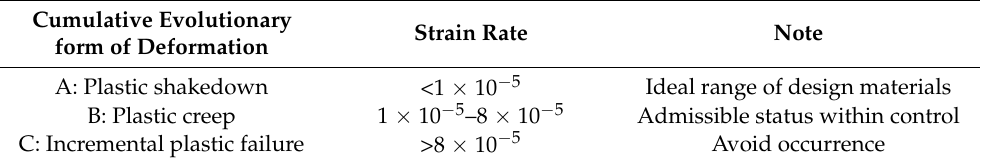
Table 2. Relationship between manner of elastoplastic response and plastic strain rate of subgrade filler.